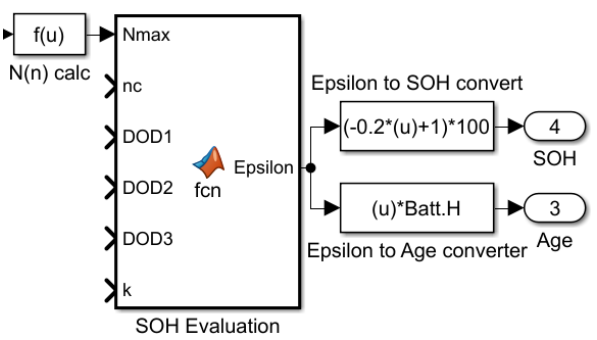
Figure 21. Block for approximation cell